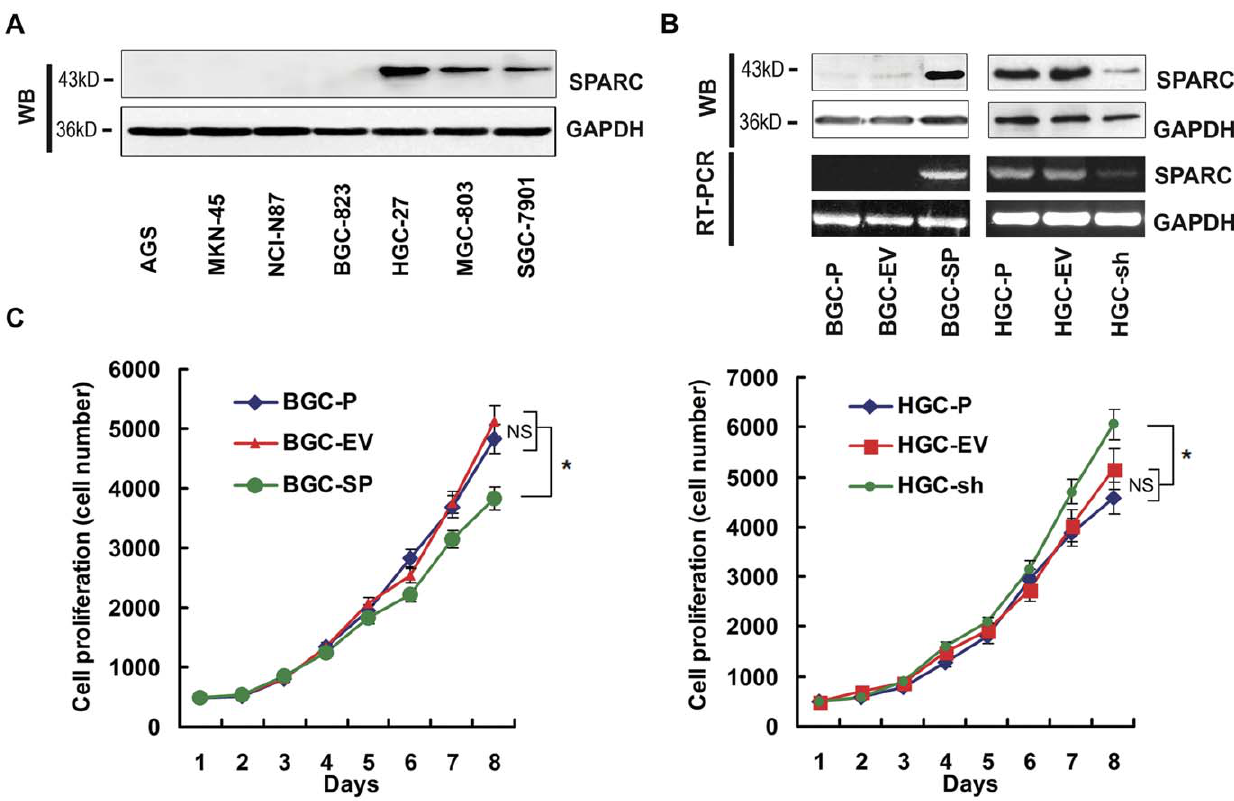
Figure 1. SPARC expression in gastric cancer cell lines, and the effects of SPARC expression alteration on cell proliferation. ( A ) SPARC protein expression in 7 types of gastric cancer cell lines. ( B ) SPARC protein (upper panel) and mRNA (lower panel) expression in parental cells (BGC-P and HGC-P), empty vector transfected clones (BGC-EV and HGC-EV), SPARC cDNA–expressing clone (BGC-SP) and SPARC shRNA-expressing clone (HGC-sh). GAPDH served as loading control. ( C ) Cell proliferation was determined by MTT assay. BGC-P and HGC-P cells and transfected clones (500 cells) were cultured in 96-well plates and incubated for 8 days, and cell proliferation was assayed by MTT method. Results are shown as means ( 6 s.d.) of quadruplicate determinations from six separate